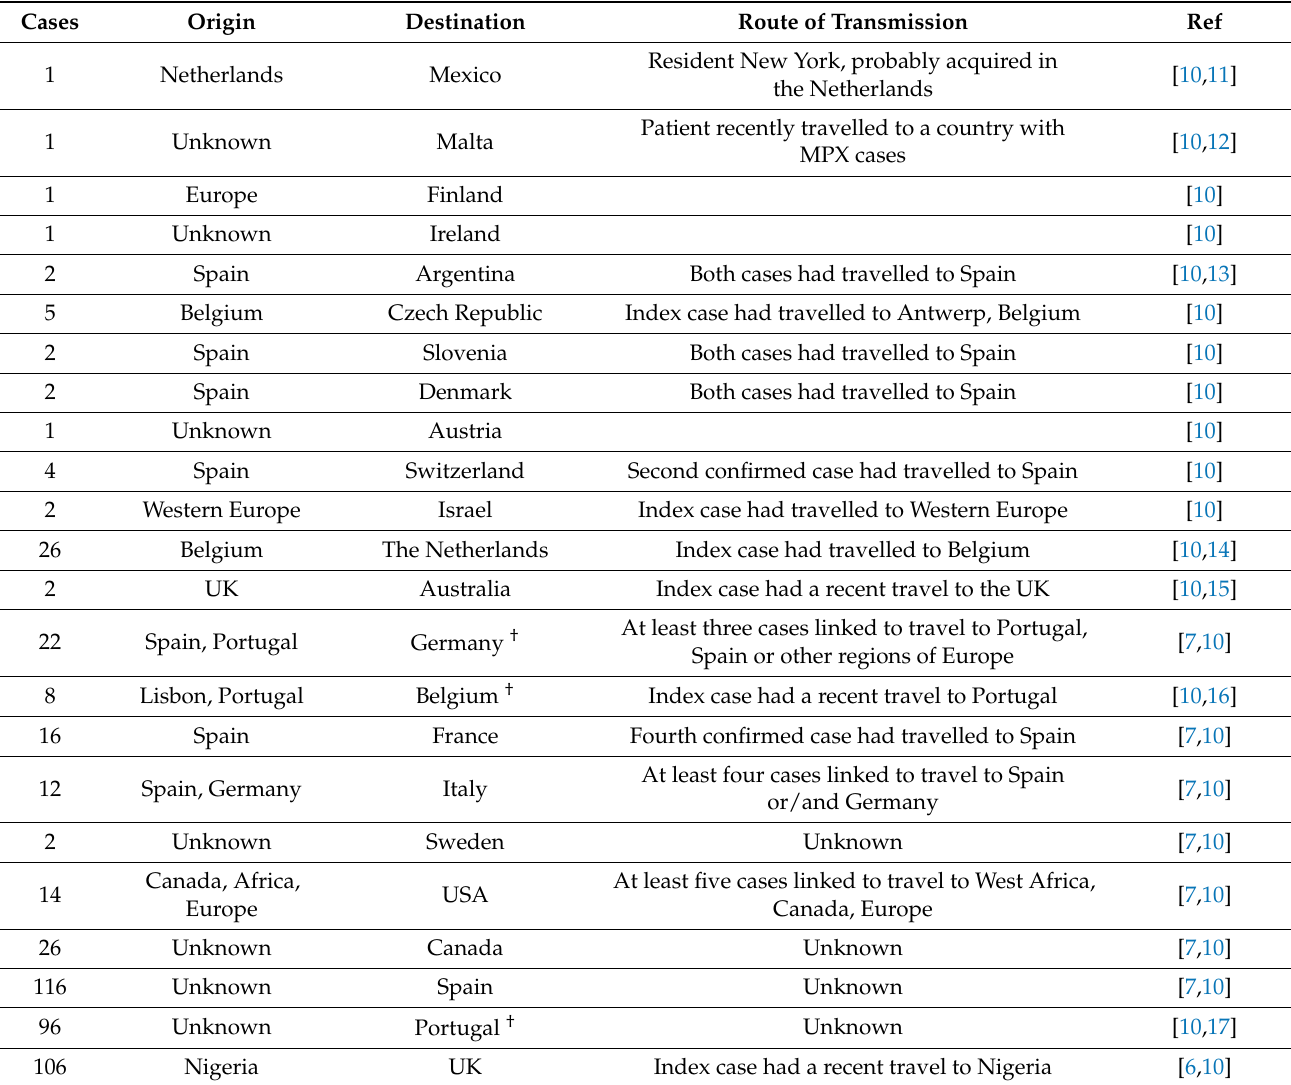
Table 1. List of laboratory-confirmed cases of human monkeypox (MPX) outside of Africa in May, 2022. Few cases linked to West African clade †